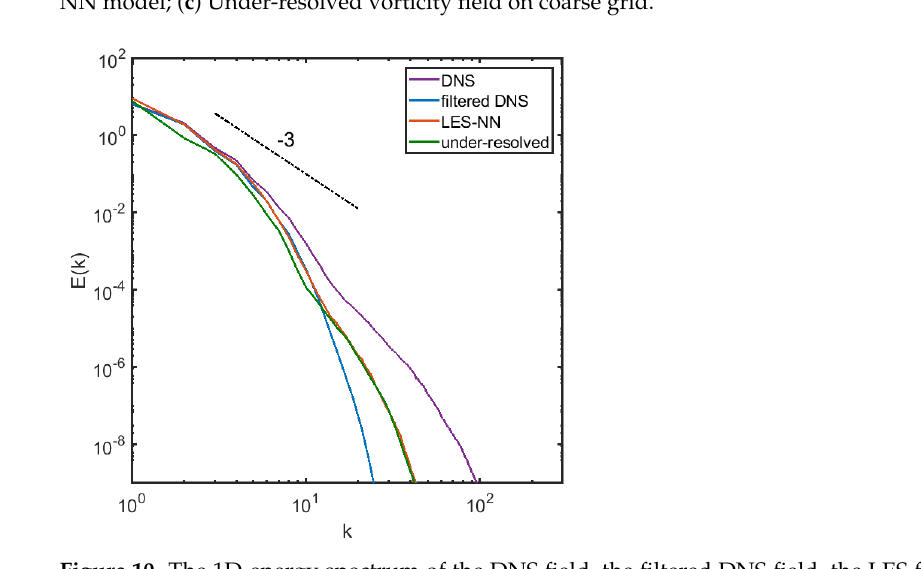
Figure 10. The 1D-energy spectrum of the DNS field, the filtered DNS field, the LES field and the coarse grid